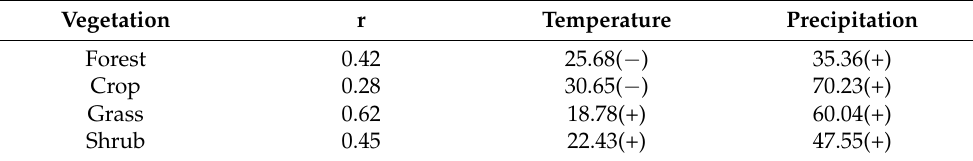
Table 2. Response of VG to climate change in dry seasons in Mara River Basin. Vegetation r Temperature Precipitation Forest